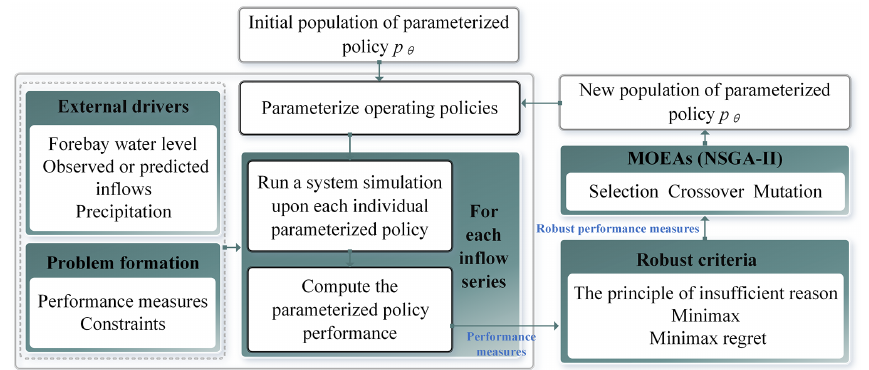
Figure 3. Schematization of the parameterized MORDM methods.